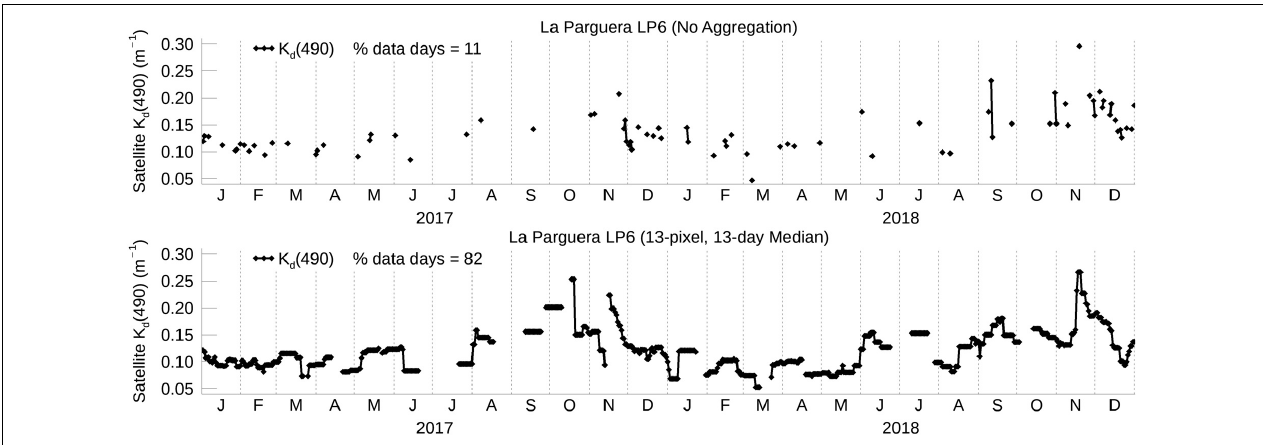
FIGURE 8 | Time Series of K d (490) from 2017 to 2018 at La Parguera, Puerto Rico Station LP6 before aggregation (top) and after taking the median from a rolling 13-pixels, 13-days spatiotemporal window centered on the date (bottom) . The RMS difference between the non-aggregated and aggregated time series is 0.025 m − 1